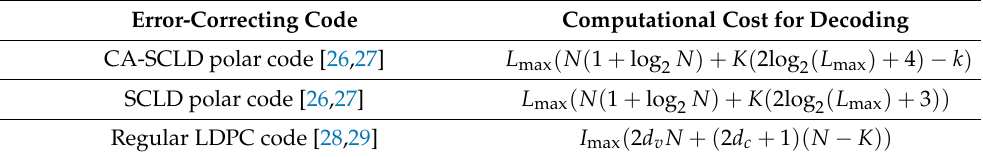
Table 3. Formulas for computational cost of error-correcting